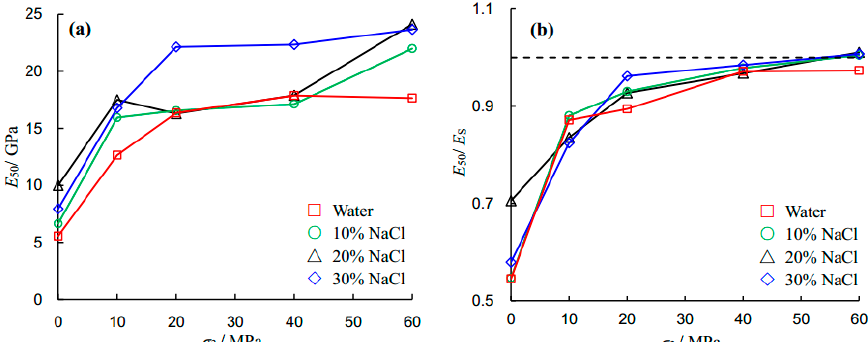
Figure 9. The influence of confining pressure and salinity level on the Young’s modulus of sandstone specimens under triaxial compression. ( a ) Deformation modulus; and ( b ) Ratio of deformation modulus to elastic modulus.